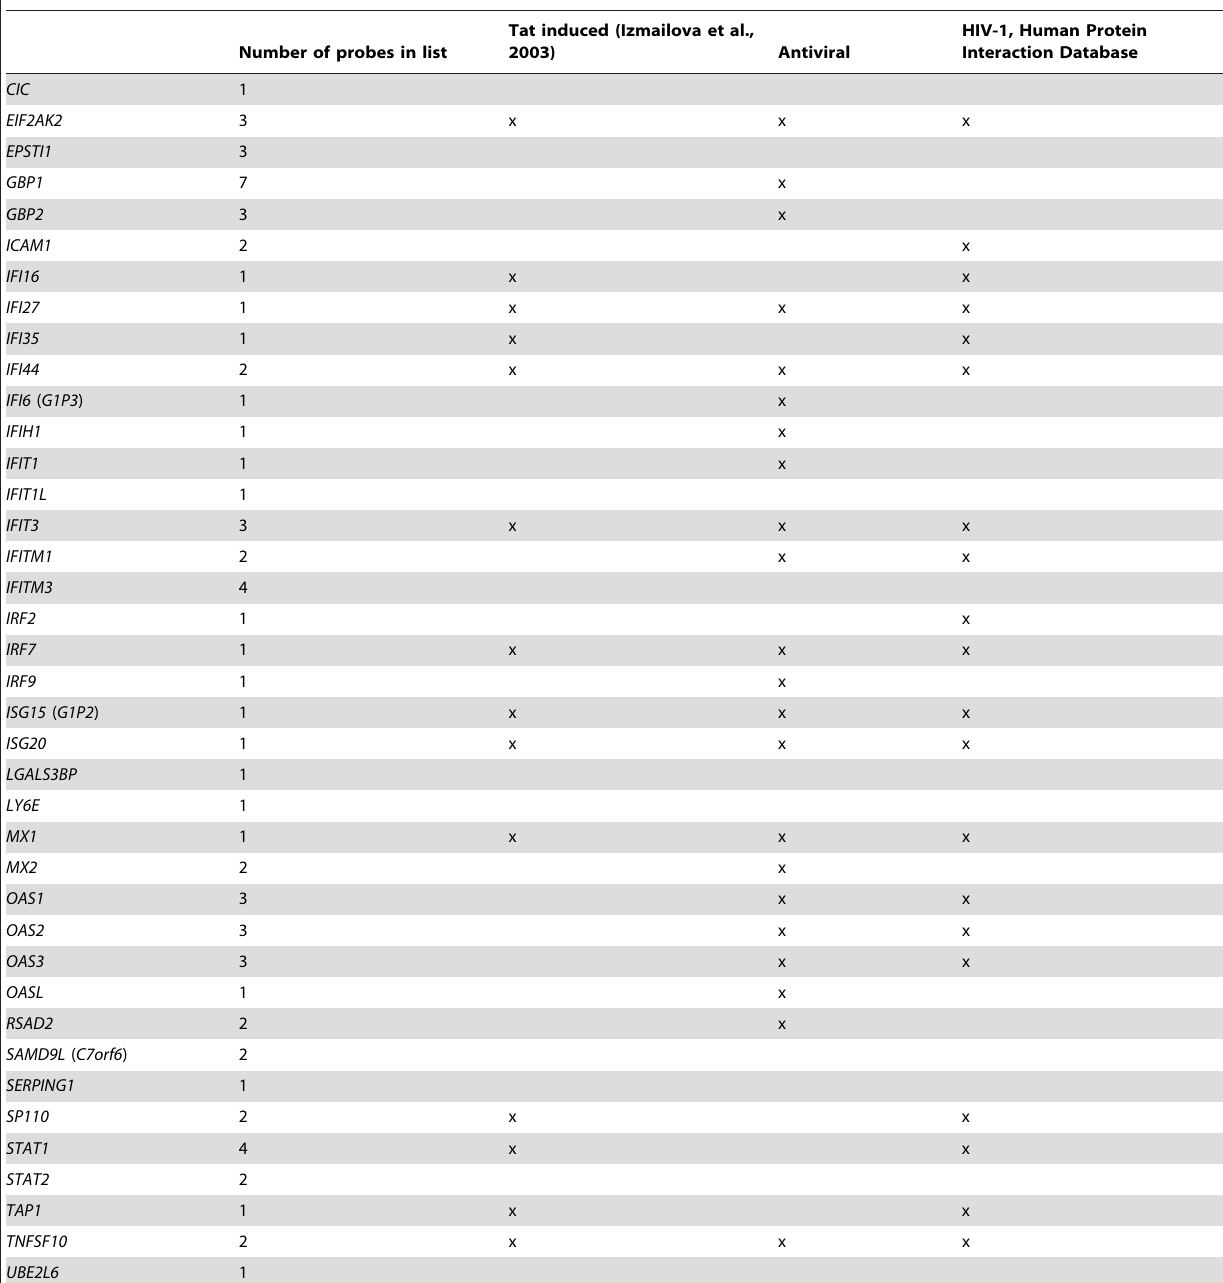
Table 1. Prototypic ISGs upregulated in the non-targeted response.